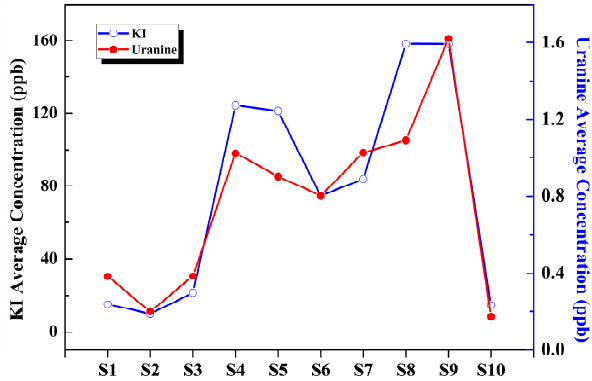
Figure 3. The average concentration of two tracers for each receiving point.